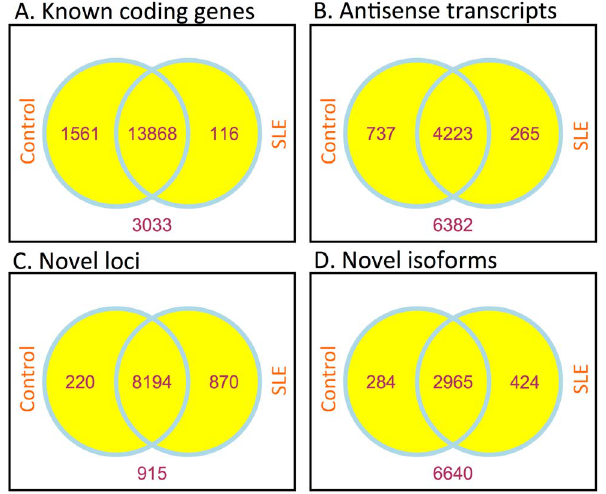
Figure 1. Comparison of SLE and control transcriptomes. The Venn diagrams demonstrate the overlap of actively transcribed A) coding genes, B) antisense transcripts, C) novel loci, and D) novel isoforms in the two sample groups. Eight control and nine SLE libraries were used. doi:10.1371/journal.pone.0093846.g001 PLOS ONE |